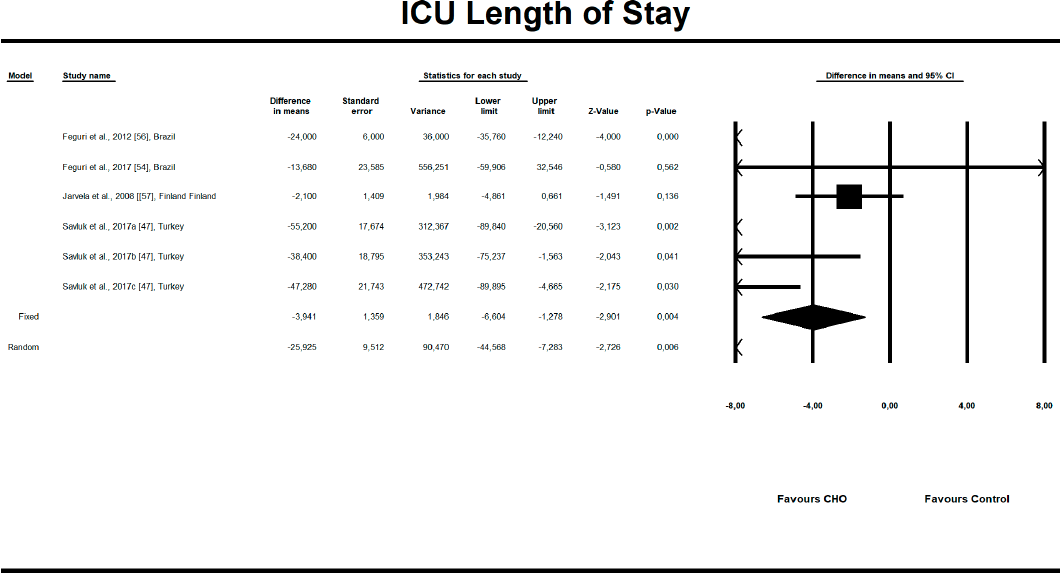
Figure 6. An effect size standardized mean difference, for exogenous insulin units (IU) in intensive care unit (ICU) postoperatively in patients taking oral carbohydrates (OCH) drinks vs. controls. Std diff in means ‐ standardized mean difference; 95%Cl – 95% confidence interval.